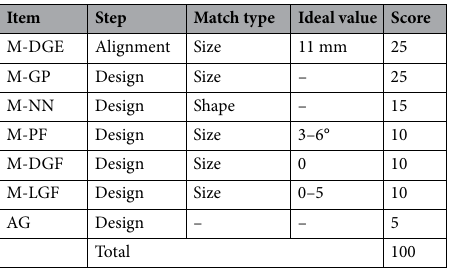
Table 1. GFS quantification.